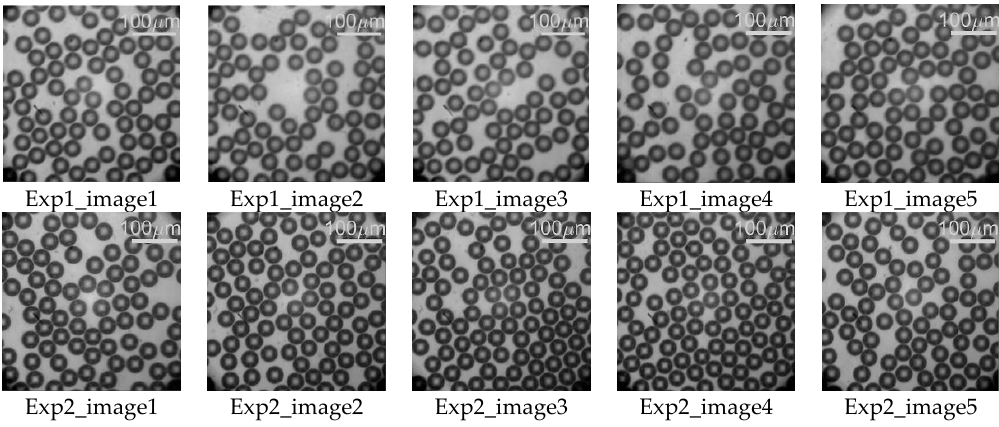
Figure 13. Bubbles acquired at the outlet of the hybrid device.